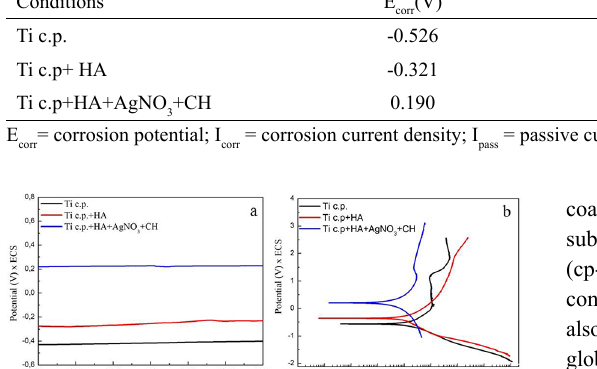
Table 3. Electrochemical parameters obtained in 1.5 SBF at 36.5ºC for cp-Ti Conditions